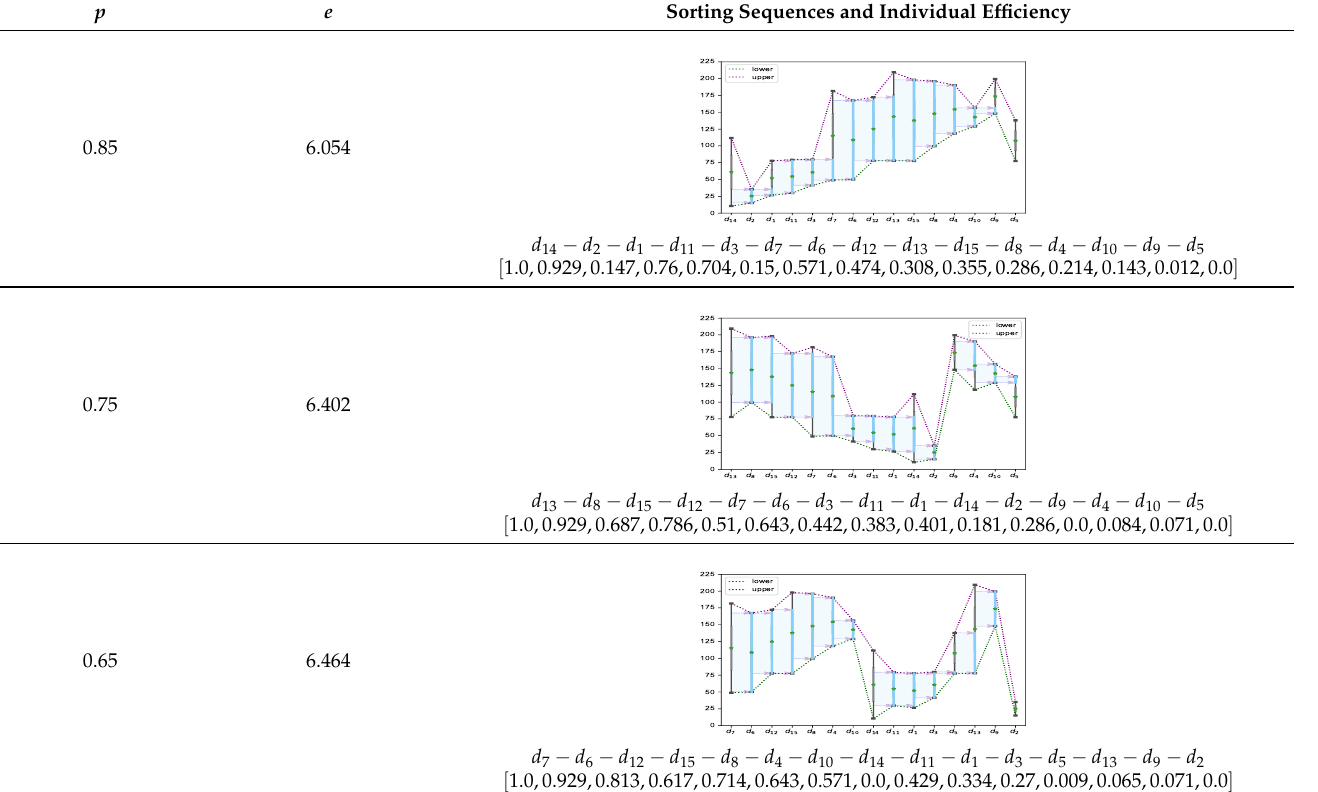
Sorting Sequences and Individual Efficiency